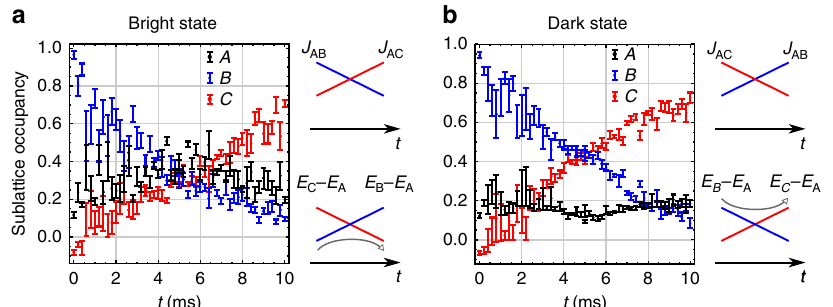
Fig. 3 Bright vs. dark state transport. a Transport from the B - to C -sublattice through the bright state. A schematic of the temporal change of the coupling constants is also shown in the right hand side. b Transport through the dark state. After loading to the B -sulattice, we exactly reverse the potential sweep applied in a . Error bars represent standard